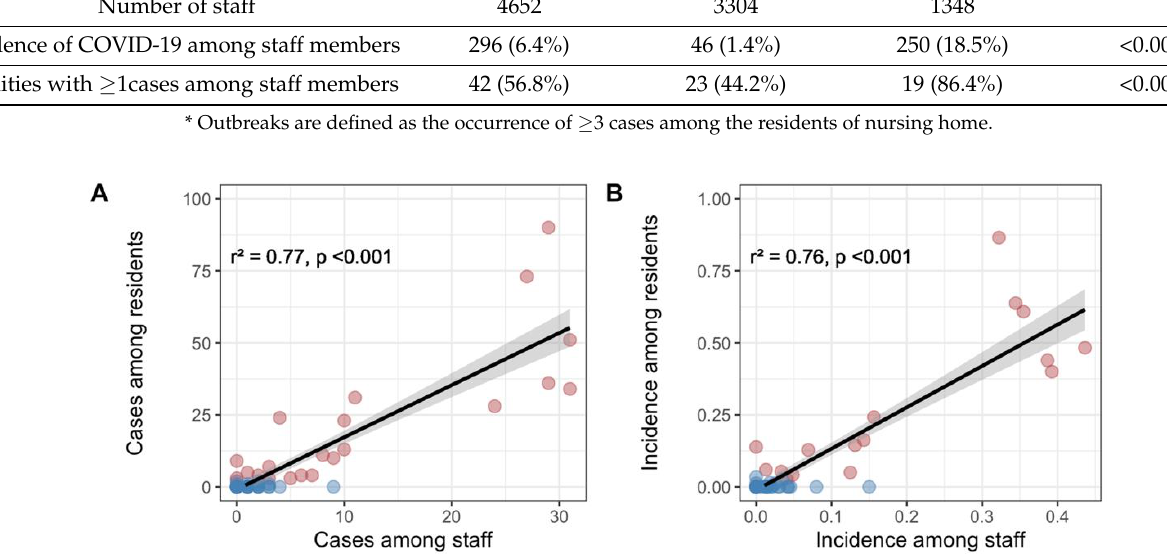
Figure 1. Linear correlations between number of cases and incidence of COVID-19 among the residents and staff members of nursing homes. The linear coefficient of determination ( r 2 ) between cases ( panel A ) and incidence ( panel B ) among residents and staff members are measured within the population of confirmed or probable cases. The red dots are representing nursing homes in which outbreaks ( ≥ 3 cases) among the residents occurred, while blue dots are representing nursing homes free of outbreak. The black line represents the linear regression line between cases in residents and in personnel, and the grey area its 95% confidence interval.